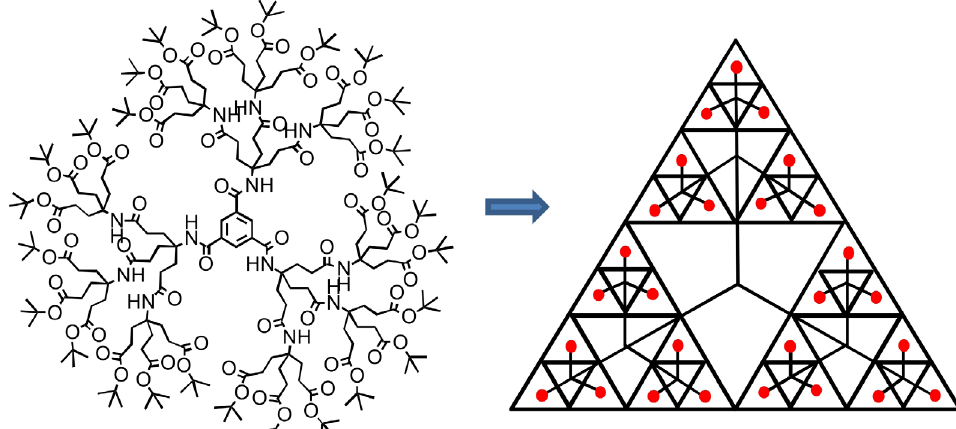
FIGURE 2 - Conceptual progression from branched dendrimer architecture to interrelated, non-tree-like fractal